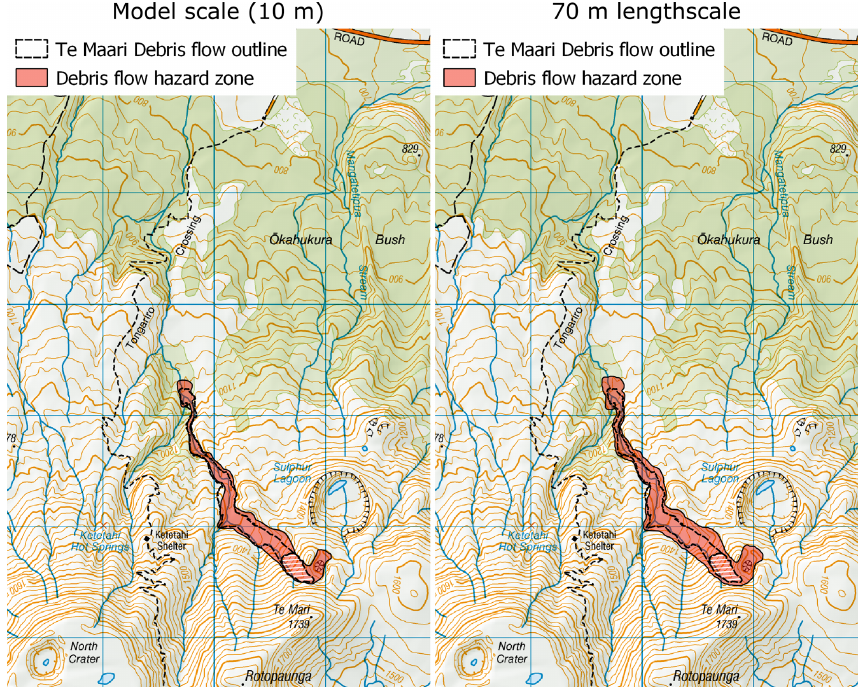
Figure 8. Hazard zones generated from simulations at (left) 10m model scale and (right) using a fuzzy length scale of 70m. Hazard outline for model scale is generated where flow heights exceed 0.5m. Hazard outline for 70m scale is generated where fuzzy quantity exceeds 0.25. Hazard zones are overlain on New Zealand Topo50 map from Land Information New Zealand (LINZ). Blue grid lines are 1km apart and are oriented north–south and